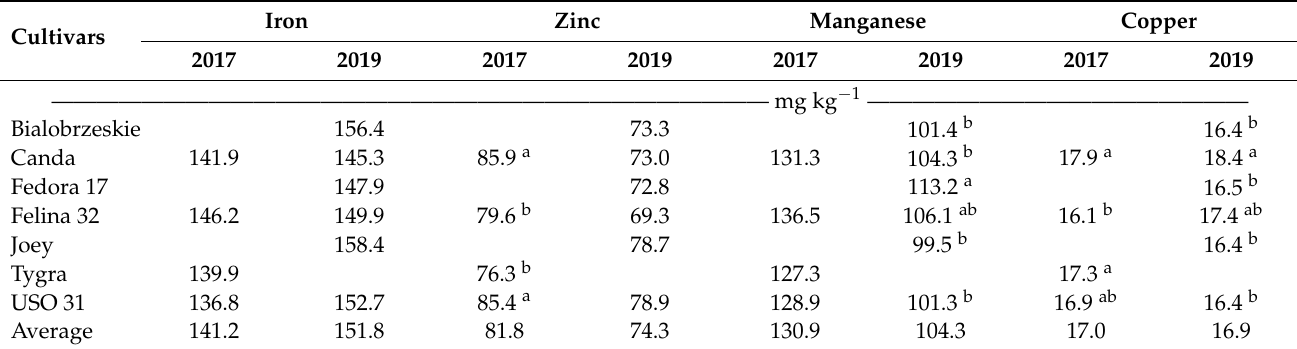
Table 6. Comparison of micronutrient element contents of hemp grain. Values are calculated means of different plant- ing dates.